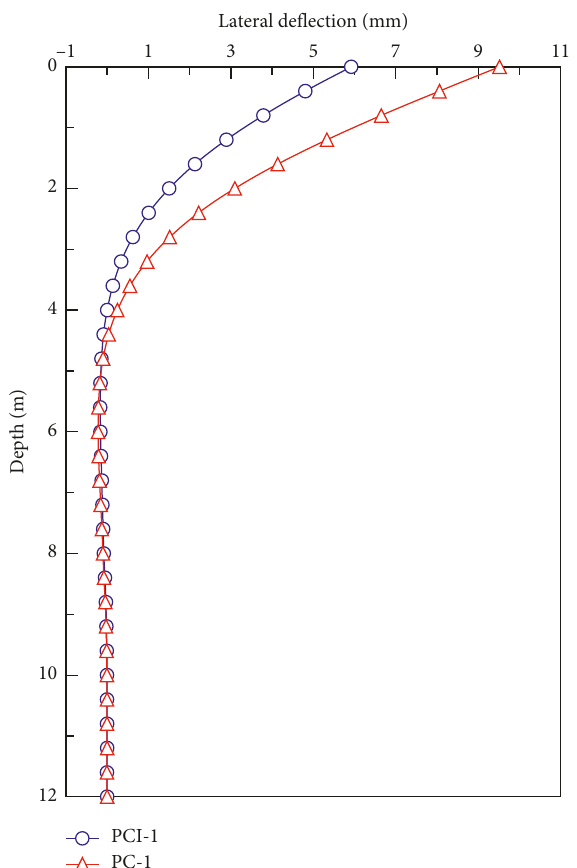
Figure 5: Computed lateral deflection along pile PCI-1 and pile PC-1 at a lateral load of 100kN.